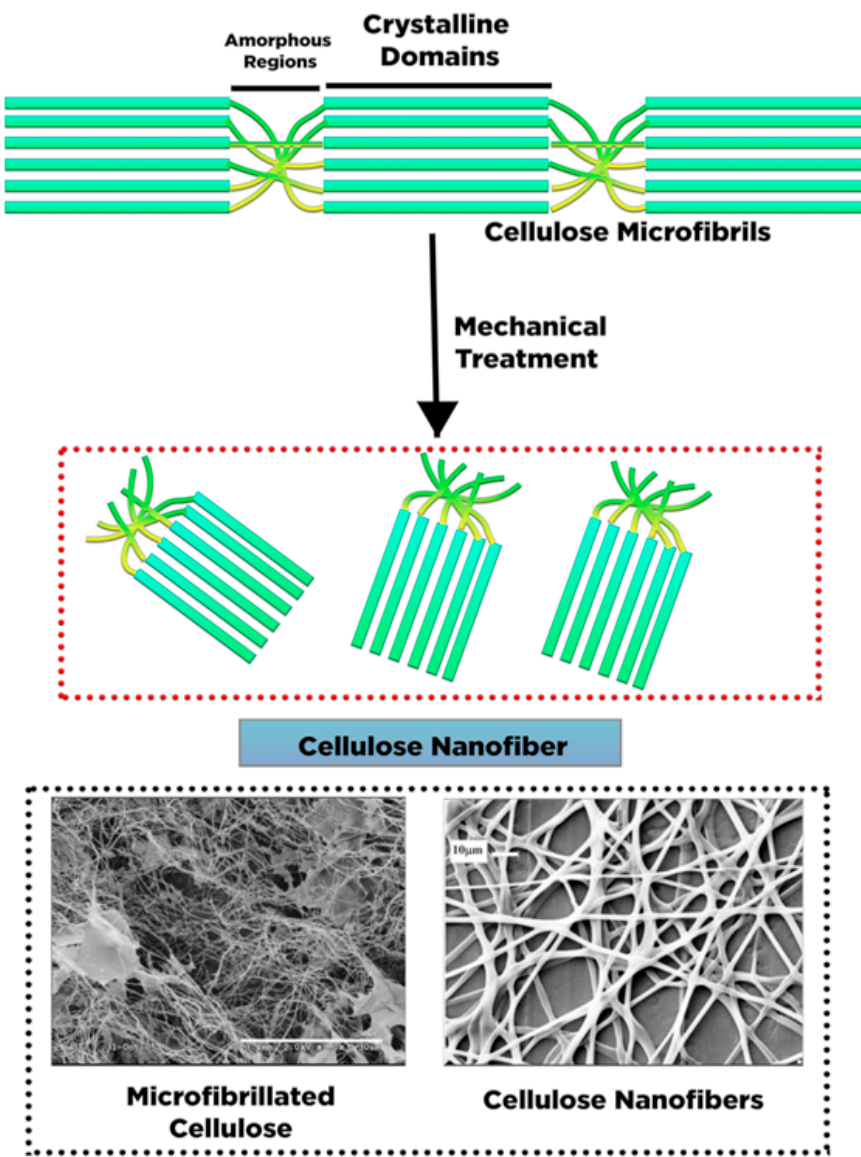
Figure 4. Schematic representation of cellulose nanofibers fabrication by mechanical treatment (scanning electron microscopy (SEM) images of micro fibrillated cellulose reprinted with permission from ref. [50]; Copyright © 2007 Elsevier Ltd.; scanning electron microscopy (SEM) images of cellulose nanofibers reprinted with permission from ref. [51]. Copyright © 2006 Elsevier Ltd.).